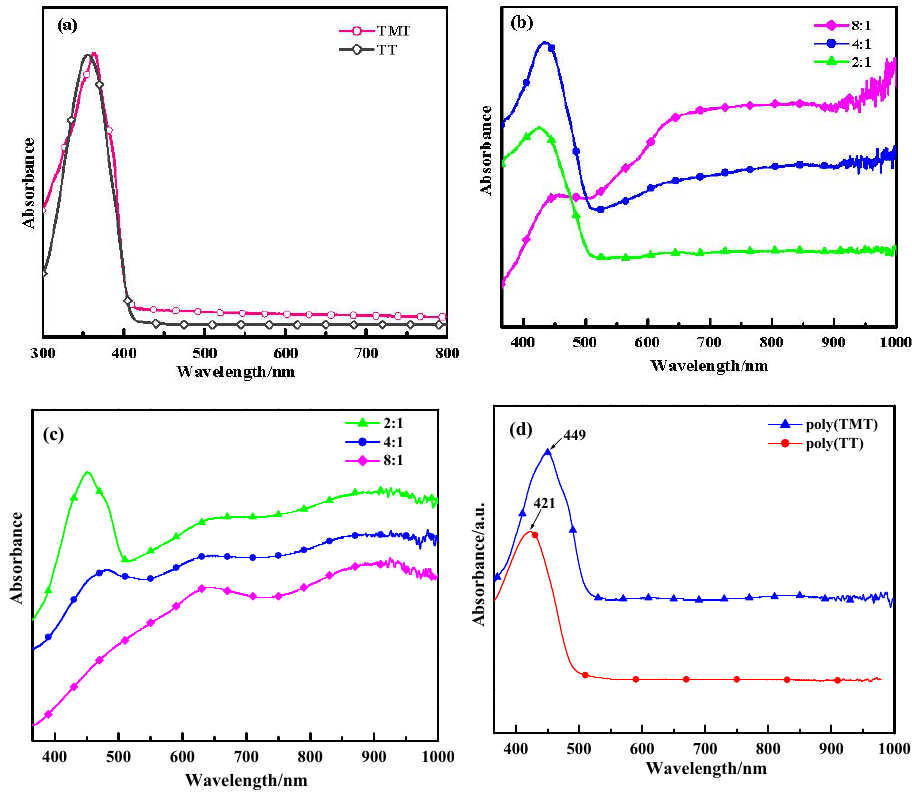
Figure 3. UV-vis of spectra of monomers and polymers: ( a ) monomers (TMT and TT); ( b ) poly(TT)s; ( c ) poly(TMT)s; [FeCl ]/[monomer] ratio: 2:1; 4:1; 8:1; ( d ) undoped 3 polymers ([FeCl ]/[monomer] ratio: 3